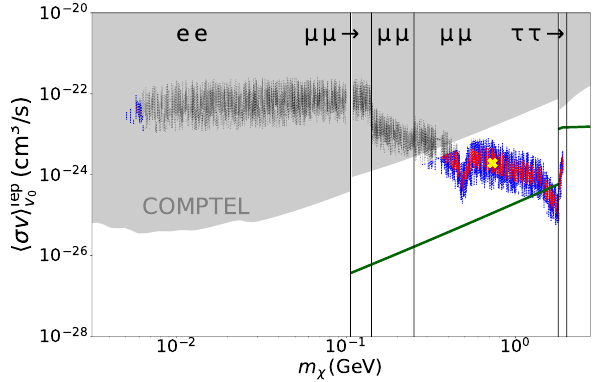
Figure 8 . The prediction of the scalar dark matter model obtained by casting the favored parameter sets discussed in section 3.5 onto the plane of the dark matter mass and the annihilation cross-section into SM lepton pairs. The colors used for the prediction are the same as those used in figure 7, except that the spread of the gray shaded area is more than in figure 7 because of the Voyager I constraint. The 90 % C.L. constraint obtained by the COMPTEL observation and the expected sensitivity from the GECCO observation are shown by gray-shaded region and a dark-green line,